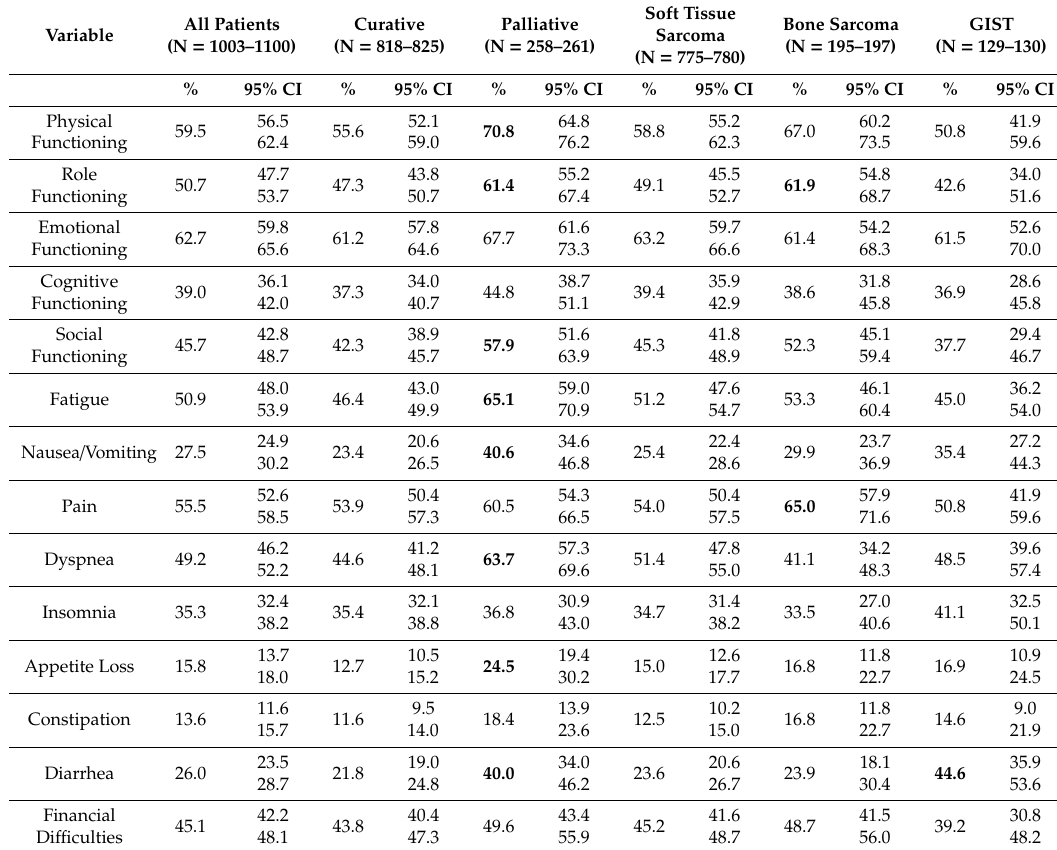
Table 2. Percentage of clinically important limitations and symptoms, stratified by treatment intention and sarcoma